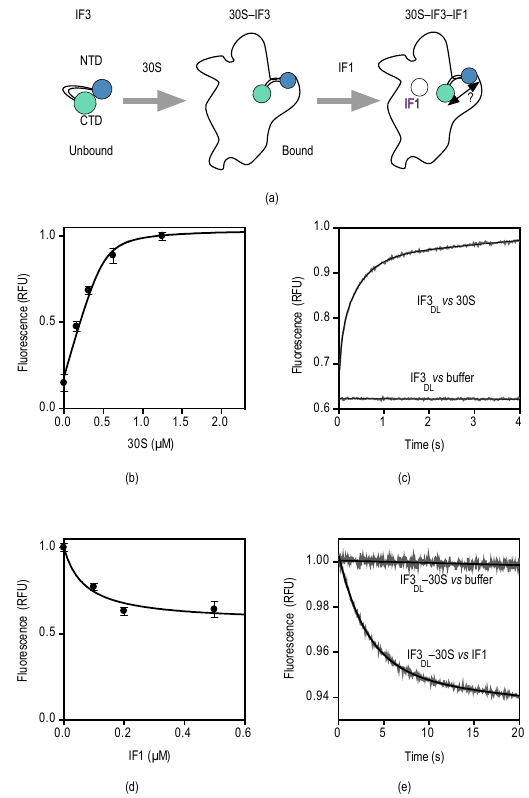
Figure 3. Steady and pre-steady binding of IF3 DL and IF1 to the 30S subunit. ( a ) Experimental scheme depicting the binding reactions of IF3 and IF1; ( b ) IF3 DL titration with increasing concentrations of 30S subunits. IF3 DL (0.5 µM) was incubated with the indicated concentrations of 30S subunits for 10 min. 5 replicates of 2 µL were measured in a NanoDrop 3000 fluorimeter (Thermo Fisher Scientific, Waltham, MA, USA). Error bars indicate standard deviations (SD). Continuous line shows fitting with a quadratic equation for binding (see Materials and Methods). ( c ) Time courses of IF3 DL binding to 30S subunits and a buffer control to assign the specific amplitude change. 30S subunits (0.1 µM) were mixed with equimolar IF3 DL in a stopped-flow apparatus. Ten to 12 individual traces were recorded and averaged. Smooth lines indicate fits by non-linear regression with two exponential terms. ( d ) 30S–IF3 DL (0.5 µM) titration with IF1 at the indicated concentrations. Five replicates of 2 µL were measured as above. Error bars indicate standard deviations (SD). ( e ) Time courses of 30S–IF3 DL binding to IF1 and a buffer control to assign the specific amplitude change. See Figure S3 for no acceptor controls. 30S–IF3 DL complexes (0.1 µM) were mixed with a 10-fold molar excess of IF1 (1 µM) in a stopped-flow apparatus. Twelve individual traces were recorded and averaged. Smooth lines indicate fits by non-linear regression with a single exponential term.